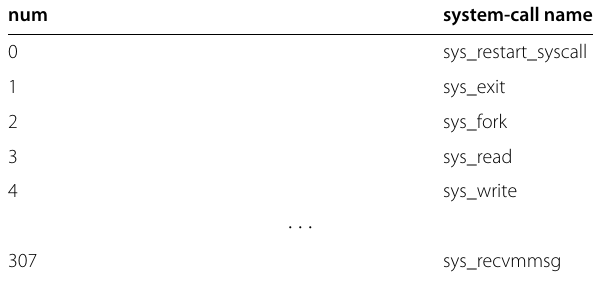
Table 3 Examples of correspondences between numbers and